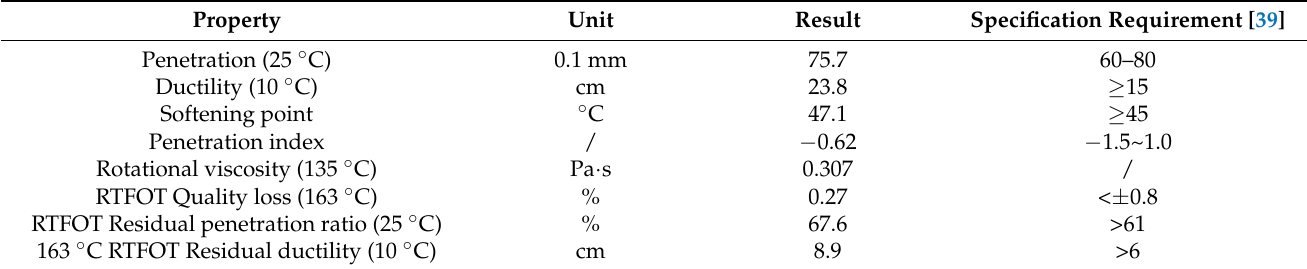
Table 1. Physical parameters of base asphalt.